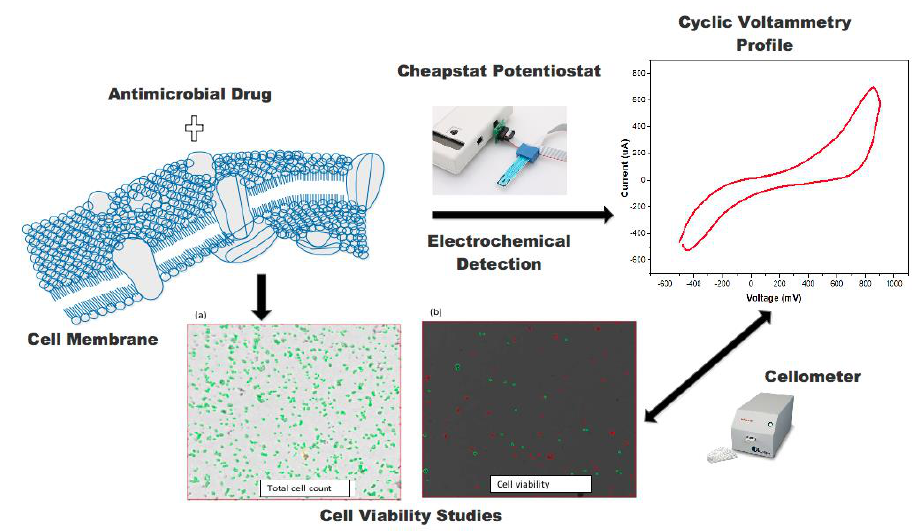
Figure 2. Schematic illustration of the mechanism of drug interaction with biological membranes and how its electrochemical response (using a miniature electrode) correlates to cell viability, as captured by the cell counting device (Cellometer).